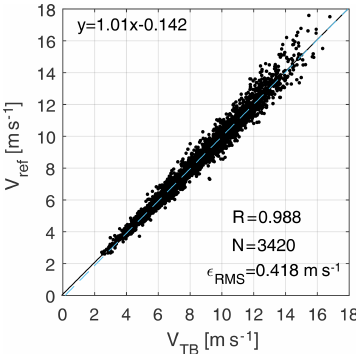
Figure 5. Torque-balance-based rotor-effective wind speed V TB (Eq. 2a) vs. met-mast reference wind speed V ref (Eq. 8).